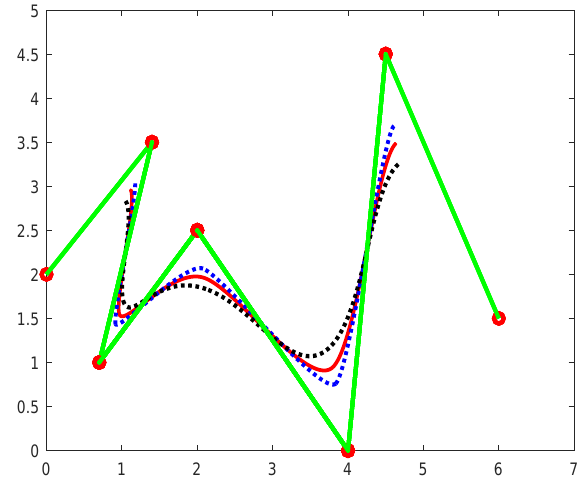
Figure 10. Effect of SP on an open B-spline curve.